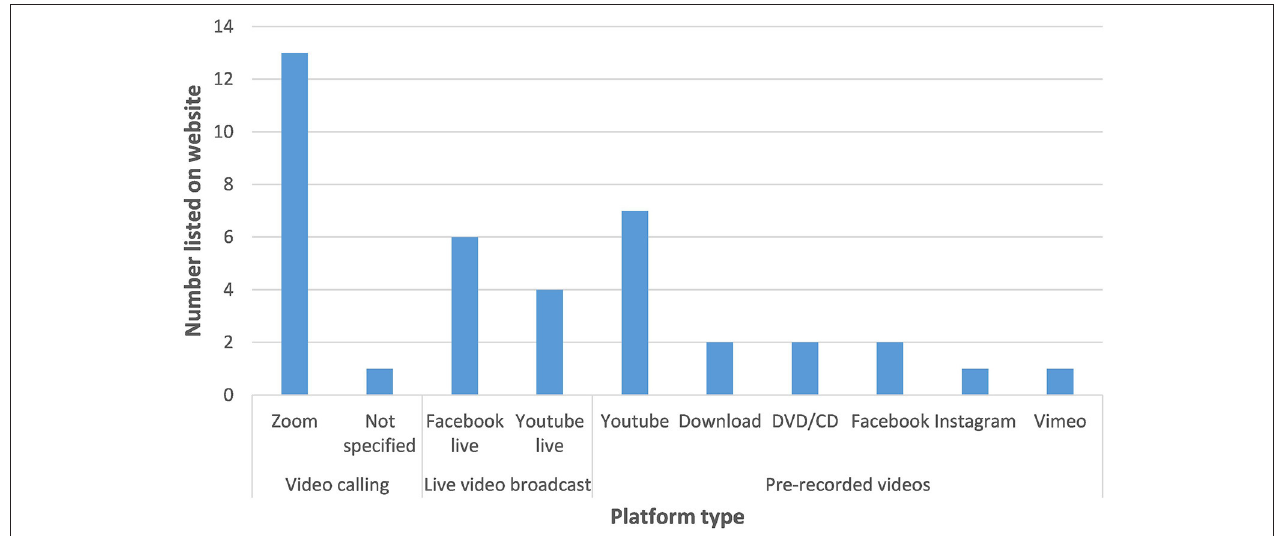
clients, engaging in phone singing built confidence and led